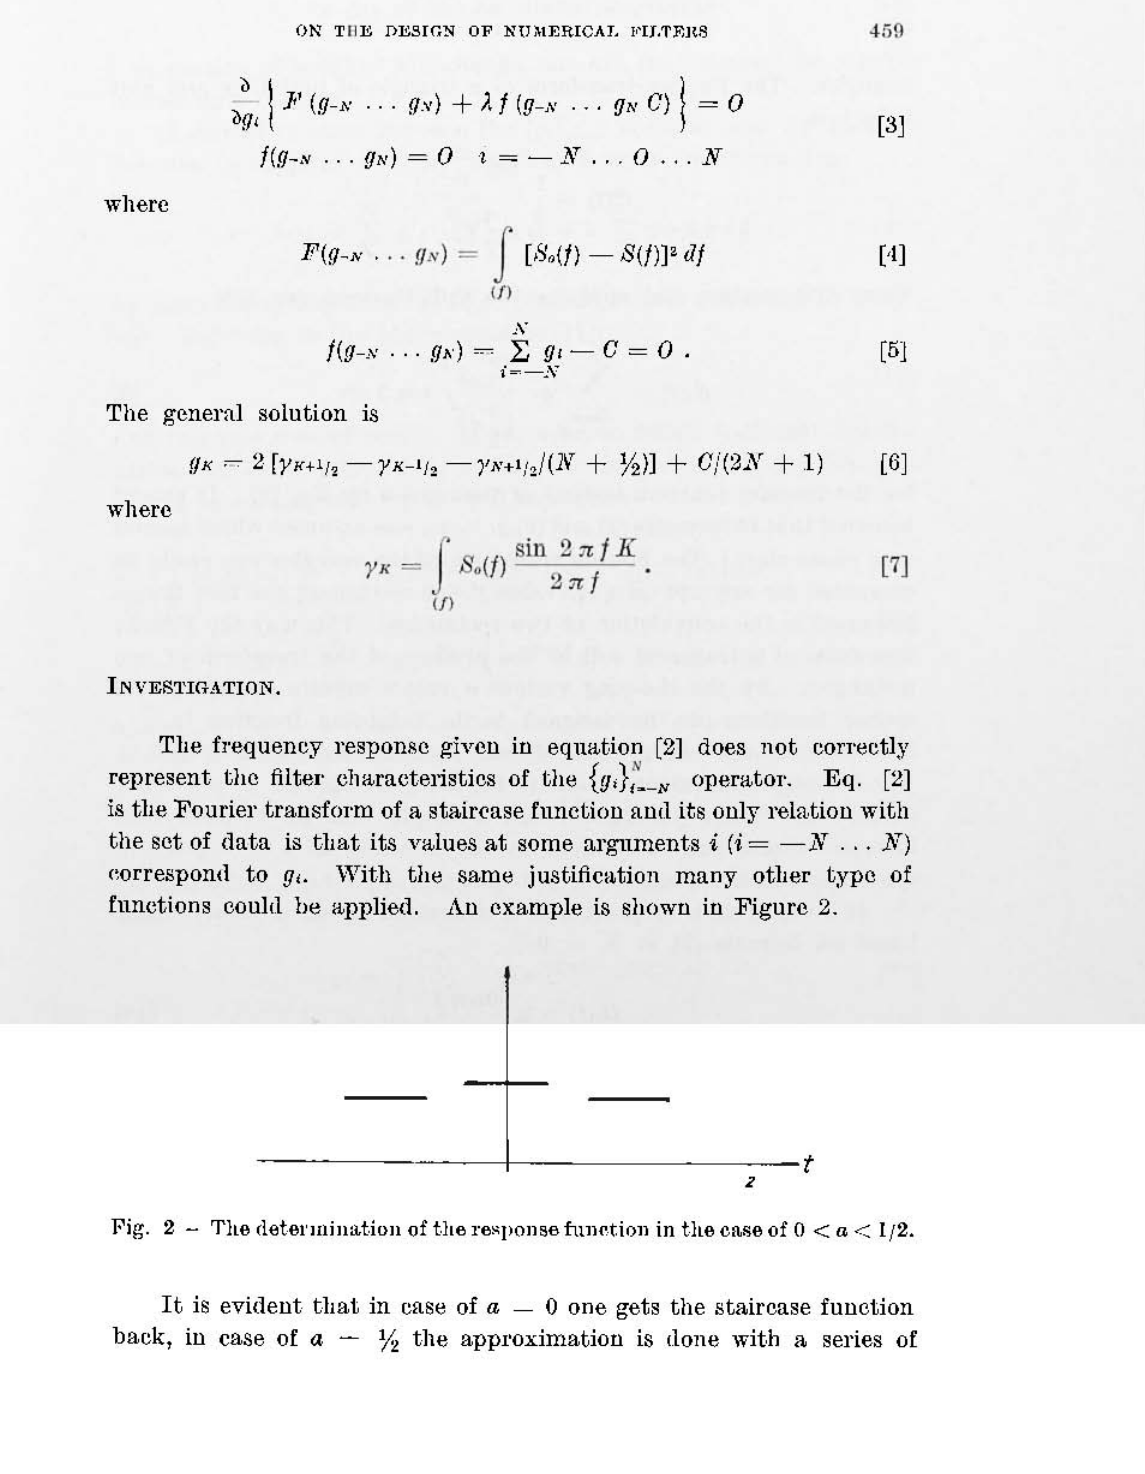
Fig. 2 - TlLe detel'lnination of the re~ponse nUH'tioll in tlLe case of O < a <